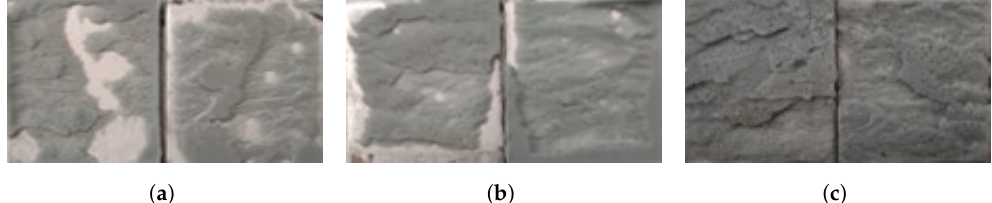
Figure 19. Fracture surfaces of aged joints with aluminum substrates with 0.5 mm ( a ), 1 mm ( b ), and 2 mm ( c ) of adhesive thickness.